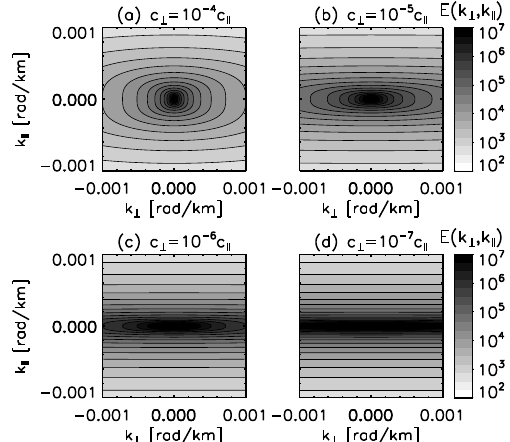
Figure 1. Two-dimensional energy spectrum for non-elliptic anisotropy (Eq. 9) for four coefficient sets: (a) c ⊥ = 10 − 4 c (cid:107) , (b) c ⊥ = 10 − 5 c (cid:107) , and (c) c ⊥ = 10 − 6 c (cid:107) , and (d) c ⊥ = 10 − 7 c (cid:107) . Wave- number range is chosen as representative of magnetohydrodynamic turbulence in the solar wind. The color bar is the spectral energy in the 2-D wavevector domain in units of nT 2 (radkm − 1 ) − 2